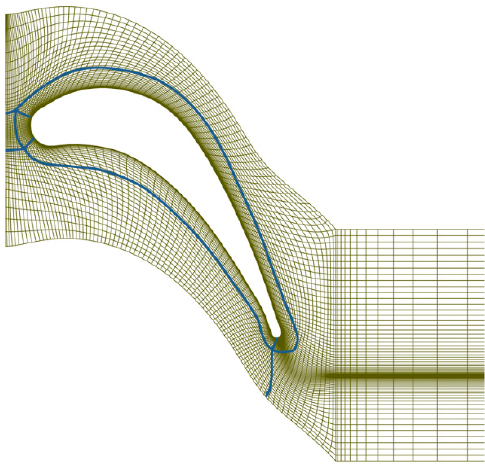
Figure 3. Blade-to-blade grid topology of stator blades (S2).